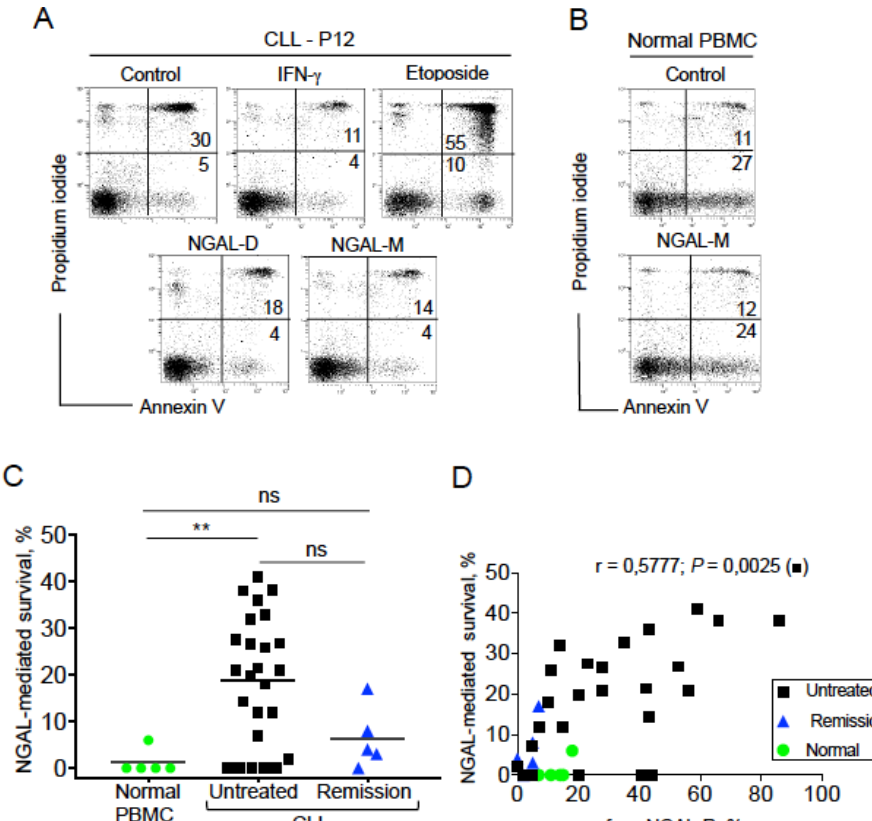
Figure 5. NGAL protects CLL cells from spontaneous death. ( A ) Representative cytograms of CLL cells cultured for 24 h in the presence or absence of 100 nM recombinant human NGAL (dimers and monomers), 1000 U/mL IFN-γ or 1 μM etoposide; detection of apoptotic cells after annexin-V-FITC/PI staining and flow cytometry. The percentage of annexin-V-positive cells is shown. ( B ) Representative cytograms of PBMCs from one healthy donor cultured for 24 h in the presence or absence of 100 nM NGAL monomers, and cell death was assessed as described in ( A ). ( C ) NGAL-mediated survival levels were determined in PBMCs from healthy individuals and CLL cells from patients before treatment or at remission. The percentage of NGAL-mediated survival is determined by subtracting the percentage of annexin-positive cells in the absence of NGAL from the percentage of annexin-positive cells in the presence of NGAL, and divided by the percentage of annexin-positive cells in the absence of stimulus x 100. The data are presented as mean ± SEM (normal PBMCs, n = 5; CLL cells from untreated patients, n = 25; CLL cells from patients in remission, n = 5). p values were calculated using a Mann–Whitney U-test; not significant (ns); ** p < 0.01. ( D ) Correlation between the levels of surface NGAL-R and NGAL-mediated survival in normal PBMCs (n = 5), CLL cells from untreated patients (n = 25) and PBMCs from patients in remission (n = 5); Spearman’s correlation coefficient (r) and the p -value are shown for untreated CLL.